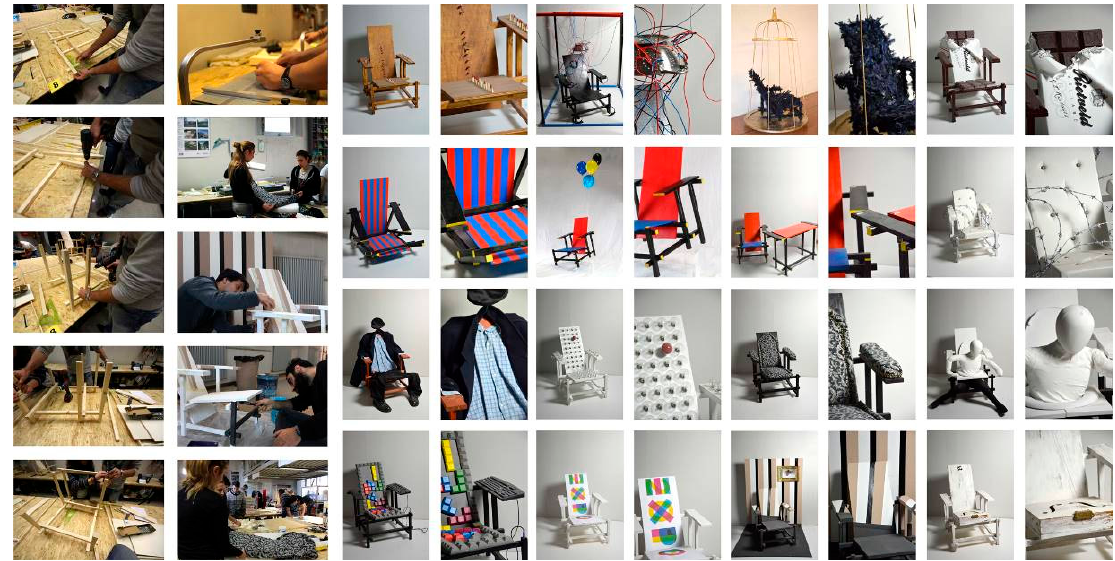
Figure 1. The creation process of the wooden models of Rietveld’s chairs and their modified